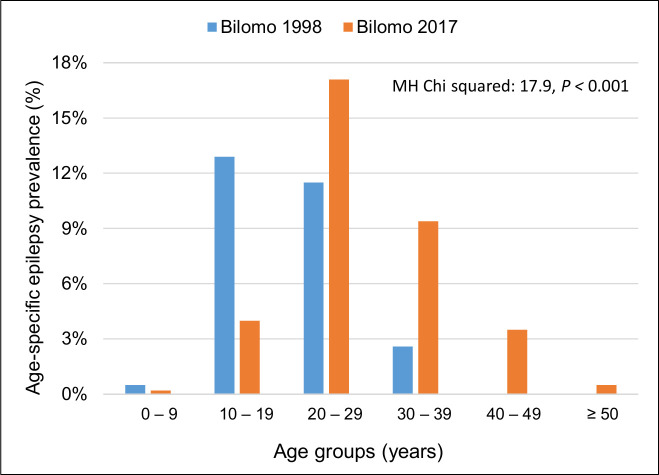
Comparison of age-specific crude prevalence of epilepsy in Bilomo, Mbam valley, Cameroon, 1998 (blue) versus 2017 (orange) [43]. MH, Mantel–Haenszel.